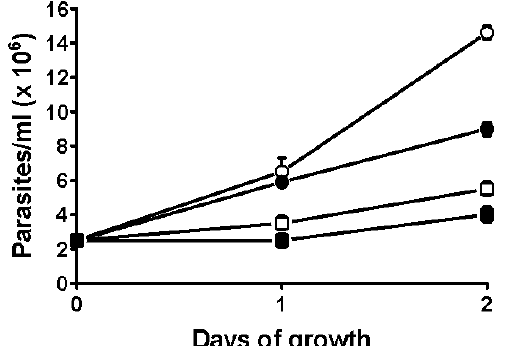
Parasites (2 × 10 6 parasites/mL) were incubated in the absence ( ○ ) or in the presence of 0.2 ( ● ), 1.0 ( □ ) or 2.5 ( ■ ) μ g/mL of the compound for 3 h, then the medium was withdrawn and replaced with fresh medium free of the compound, and the parasites were allowed to grow for 1 or 2 days. The values represent the means of three experiments ± SD.